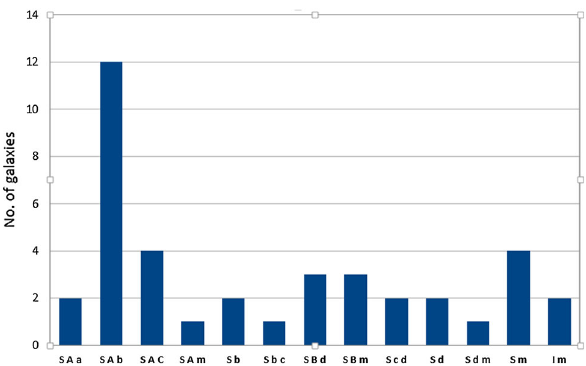
Fig. 4 Galaxy distribution according to their morphological classifi- cation